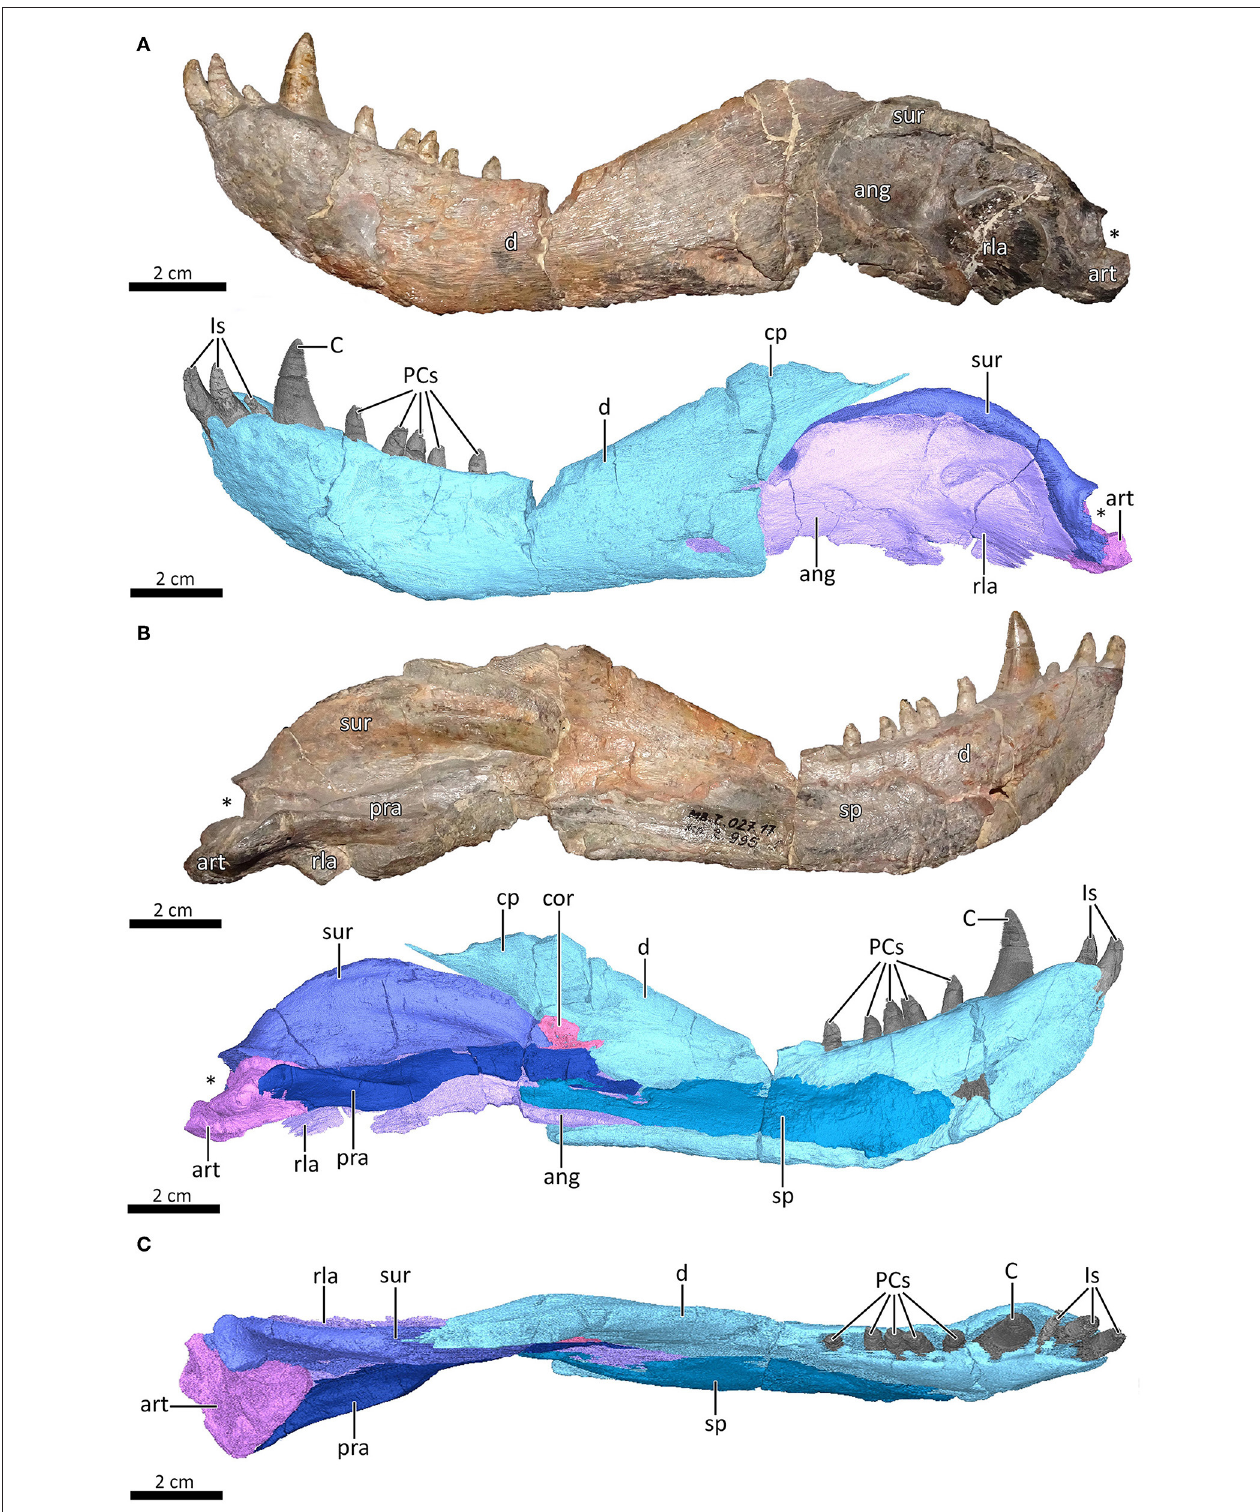
FIGURE 12 | Left mandible of MB.R.995. (A) Photograph (top) and 3D reconstruction (bottom) of the left mandible in lateral view. (B) Photograph (top) and 3D reconstruction (bottom) of the left mandible in medial view. (C) Dorsal view of the reconstructed left mandible. Asterisk indicates the location of the glenoid fossa. ang, angular; art, articular; C, lower canine; cor, coronoid; cp, coronoid process; d, dentary; Is, lower incisors; PCs, lower postcanines; pra, prearticular; rla, reflected lamina of the angular; sp, splenial; sur, surangular.